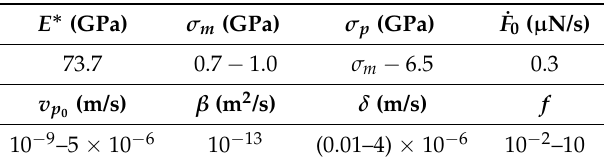
Table 2. Range of parameter values in the model equations using Berkovich indenter keeping the nominal tip radius R = 40 nm and σ n = 7.0 GPa.